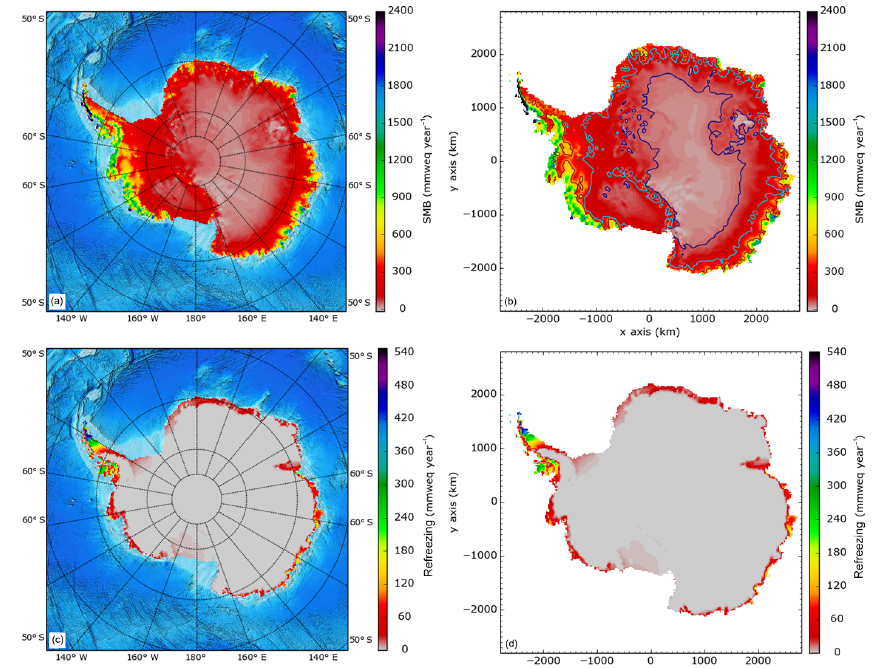
Figure 10. As in Fig. 8 but for Antarctica; the Antarctic RACMO2.3 data set is a time average over the 1979–2014 period, and the Antarctic RACMO2.3 grid resolution in (a, c) is about 27km and the Antarctic ISM grid resolution in (b, d) is 20km ×